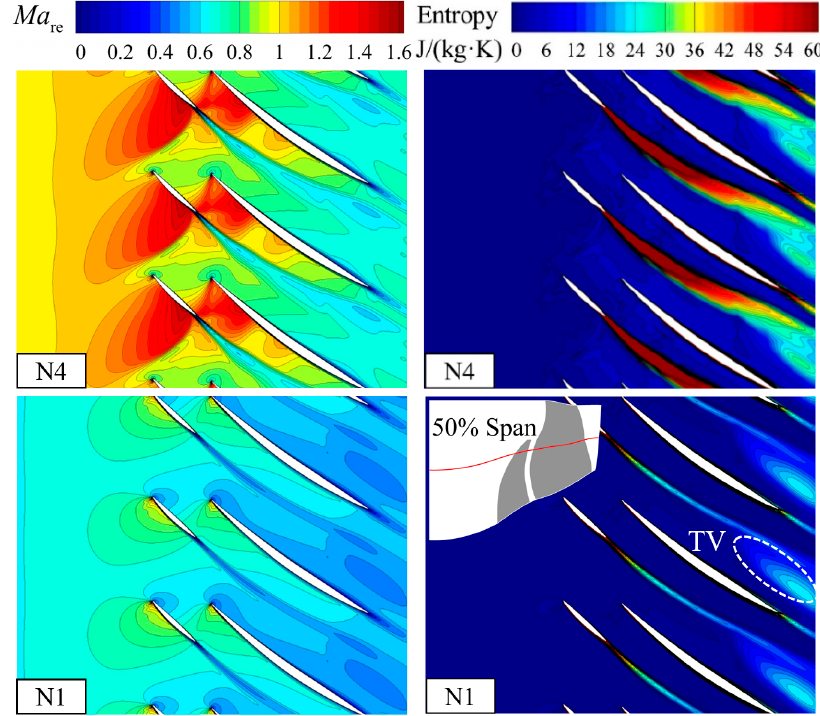
Figure 23. Ma re and entropy contour at 50% span of the tandem rotor.